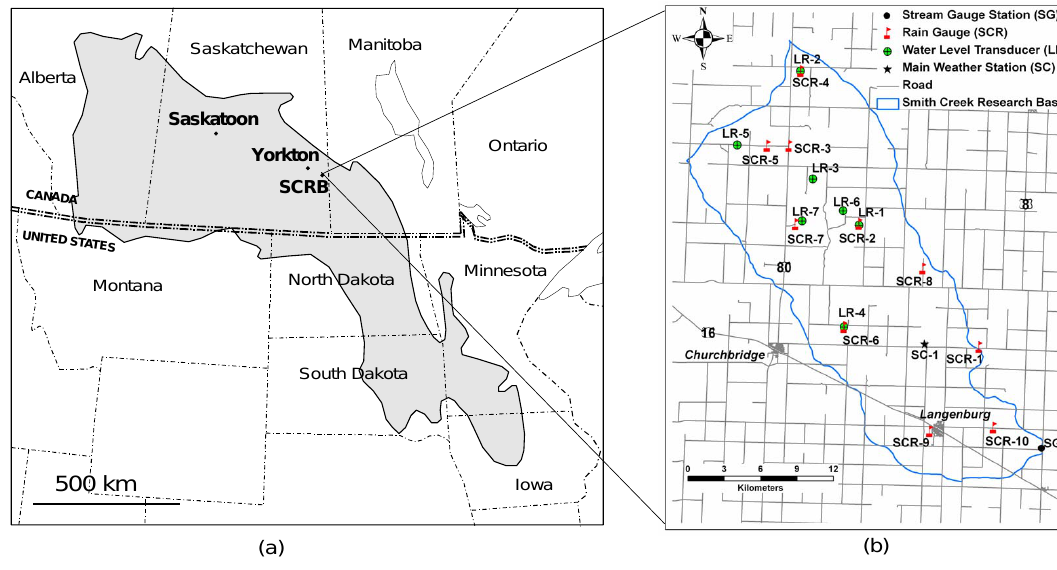
Fig. 1. (a) Extent of the semi-arid glaciated northern prairie wetland region (grey shaded area) in Canada and the United States (Winter, 1989) and the location of Smith Creek Research Basin (SCRB), and (b) extent of the SC and field observation stations of rainfall (SCR), water level (LR), hydrometeorology (SC) and streamflow